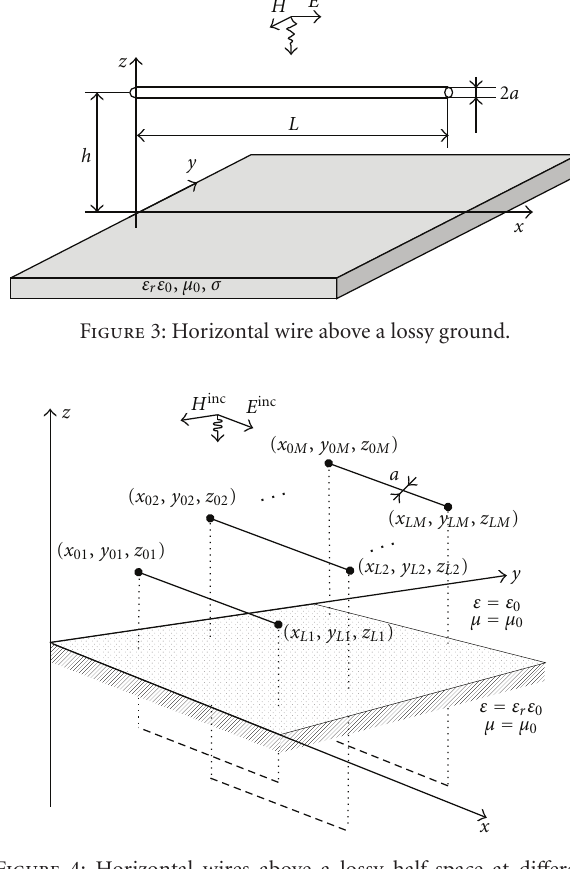
Figure 4: Horizontal wires above a lossy half-space at di ff erent